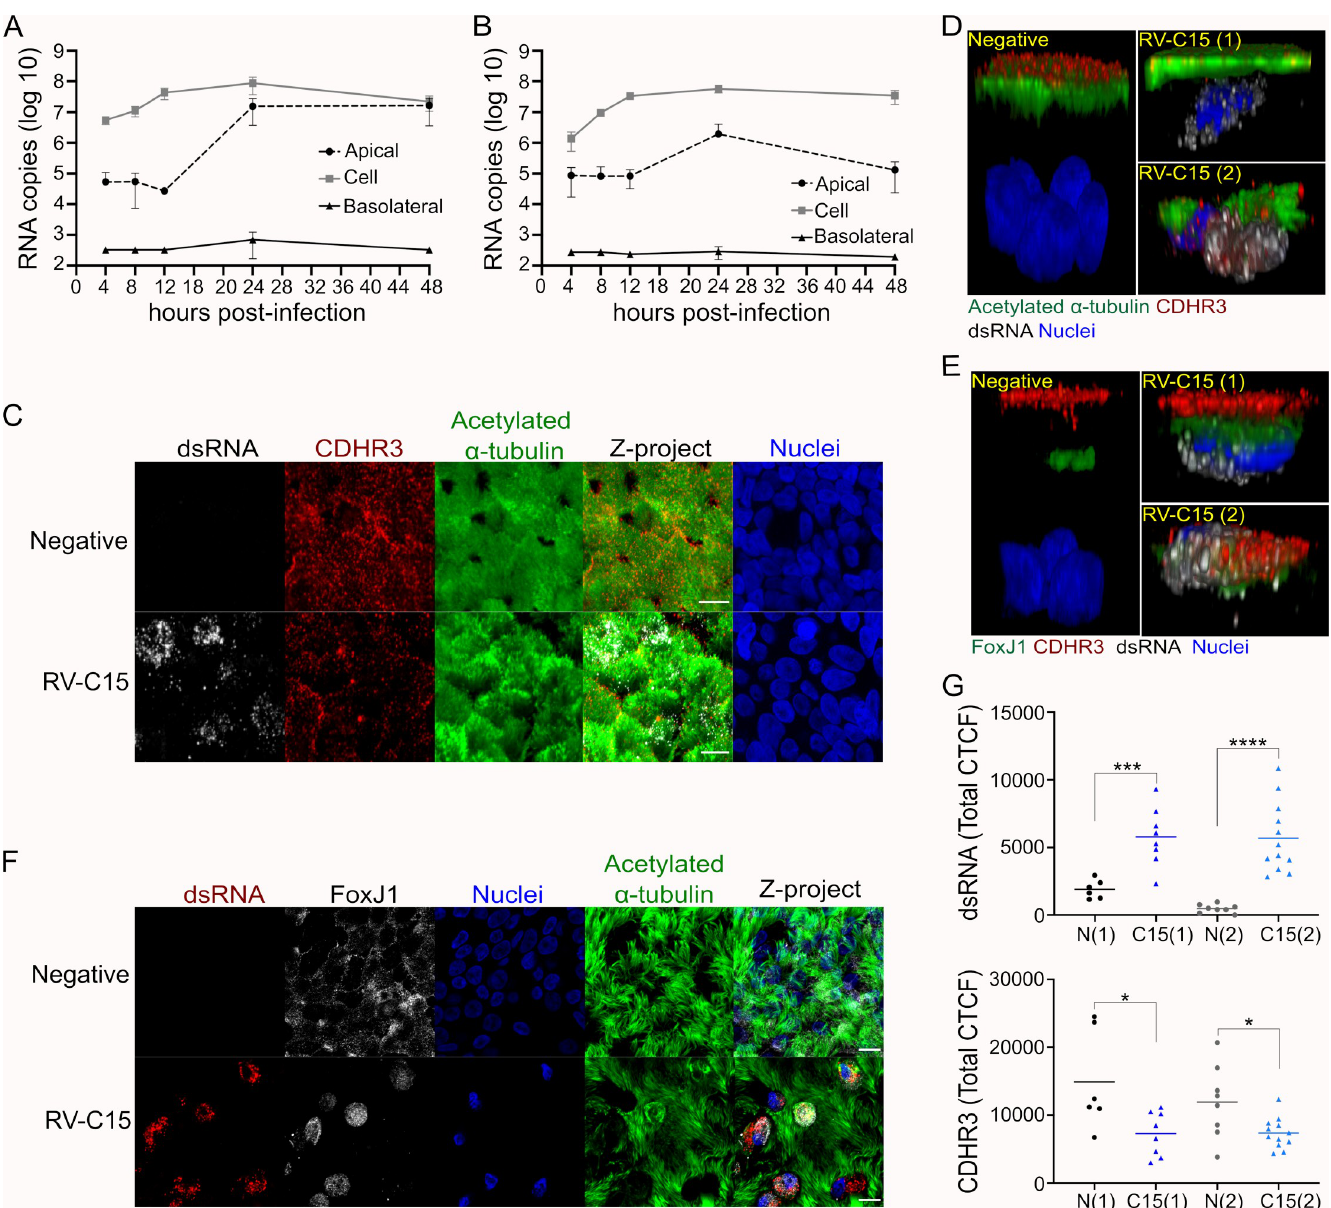
Fig 1. RV-C15 replicates in ciliated epithelial cells, leading to decreased CDHR3 levels. A and B: Multi-cycle RV-C15 growth delineated at 34˚C in HAE ( A: donor 1; B: donor 2). Data shown are the mean +/- standard deviation across n = 3 cultures/time point. C-E: Immunofluorescence detection of CDHR3 (red) in non-infected or RV-C15-infected (dsRNA+, gray) ciliated cells identified by either acetylated α -tubulin (green; C and D ) or FoxJ1 (green; E ) at 12hpi. C: scale bar = 10 μ m. D and E: 3D visualization; z-stacks were at 1 μ m of thickness). F: Immunofluorescence detection of RV-C15 replication (dsRNA; red) in ciliated cells (FoxJ1, gray) with or without motile cilia (acetylated α -tubulin, green) at 12hpi (scale bar = 10 μ m). G: Quantification of dsRNA and CDHR3 fluorescence levels (CTCF) in non-infected (N) and RV-C15-infected (C15; dsRNA+) ciliated cells following immunofluorescence staining at 12hpi. Graphs show dsRNA and CDHR3 total CTCF (line = mean) quantified in HAE using FoxJ1 (N(1) and C15(1)) or acetylated α -tubulin (C15(2) and N(2)) as a marker of ciliated cells. Dots represent the sum of all fluorescence intensity (Total CTCF) quantified per cell. Statistical analysis was done using the Mann-Whitney U test (Two-tailed; 0.95% confidence interval; � p < 0.05, ��� p < 0.001, ���� p <